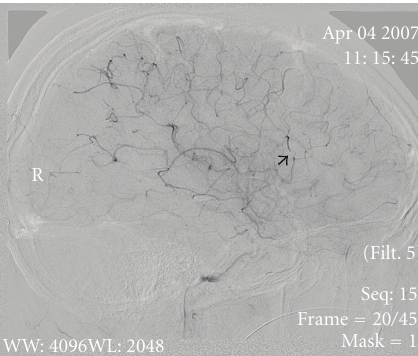
Figure 5: Sagittal view demonstrating a significant improvement in blood flow after rt-PA Abciximab and nitroglycerin were infused. Arrow points to a small residual occlusion.